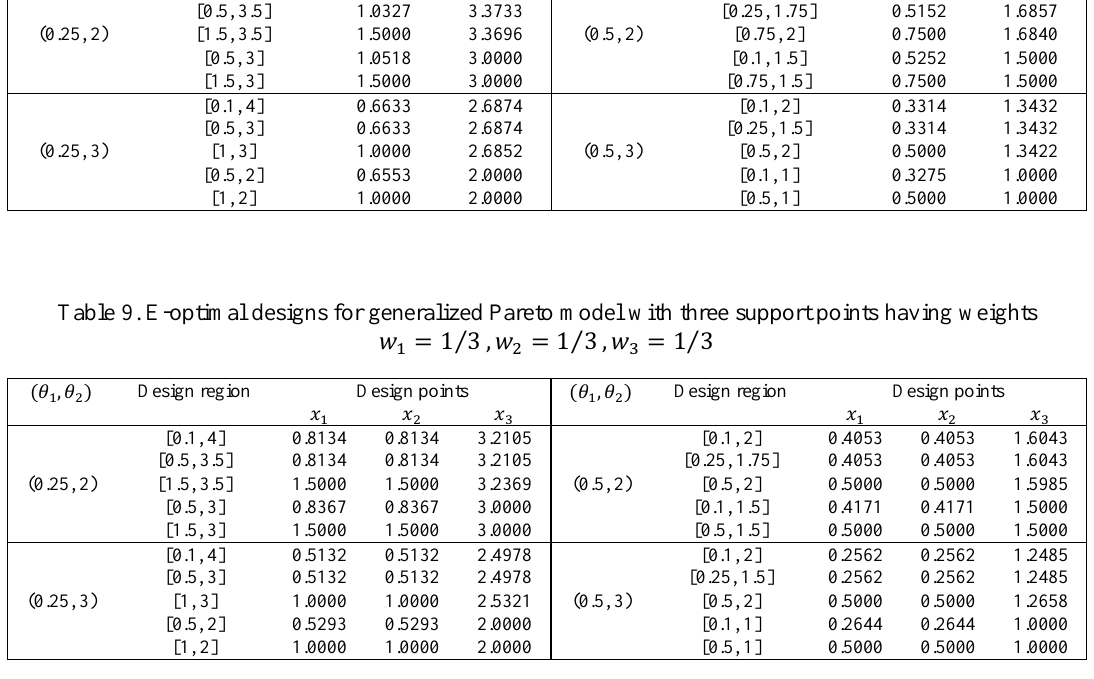
Table 8. E-optimal designs for generalized Pareto model with two support points having weights